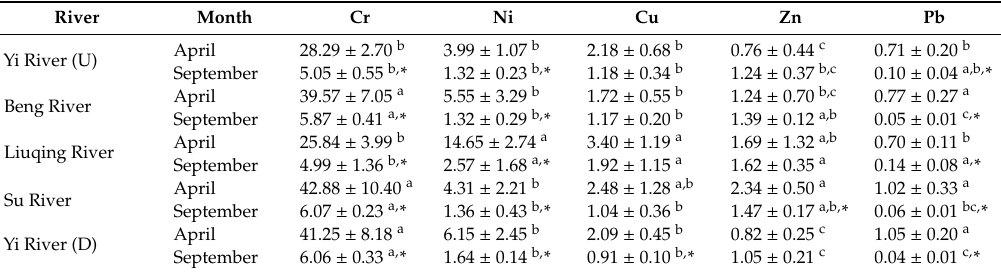
Values represent mean and standard deviation. In each column, di ff erent superscript letters indicate significant di ff erence ( p < 0.05) between sampling sites for the same heavy metal and same sampling time; “*” means significant di ff erence ( p < 0.05) between di ff erent months for the same metal and sampling